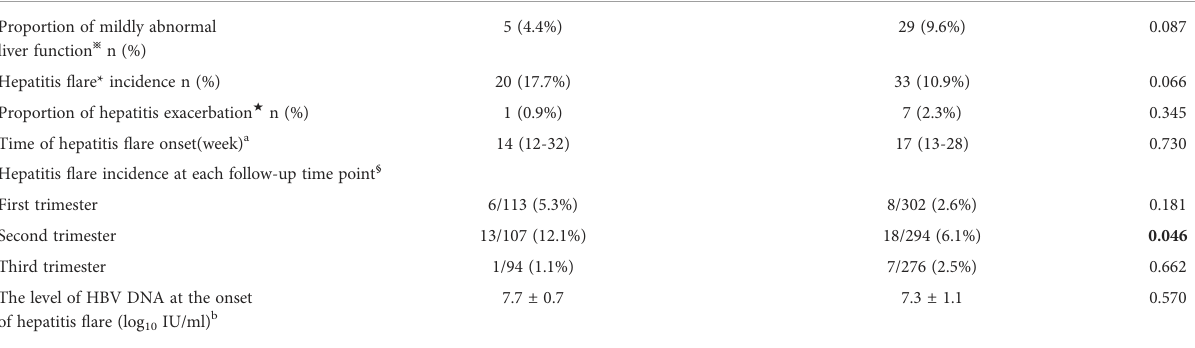
TABLE 2 Incidence of hepatitis fl are during pregnancy in two